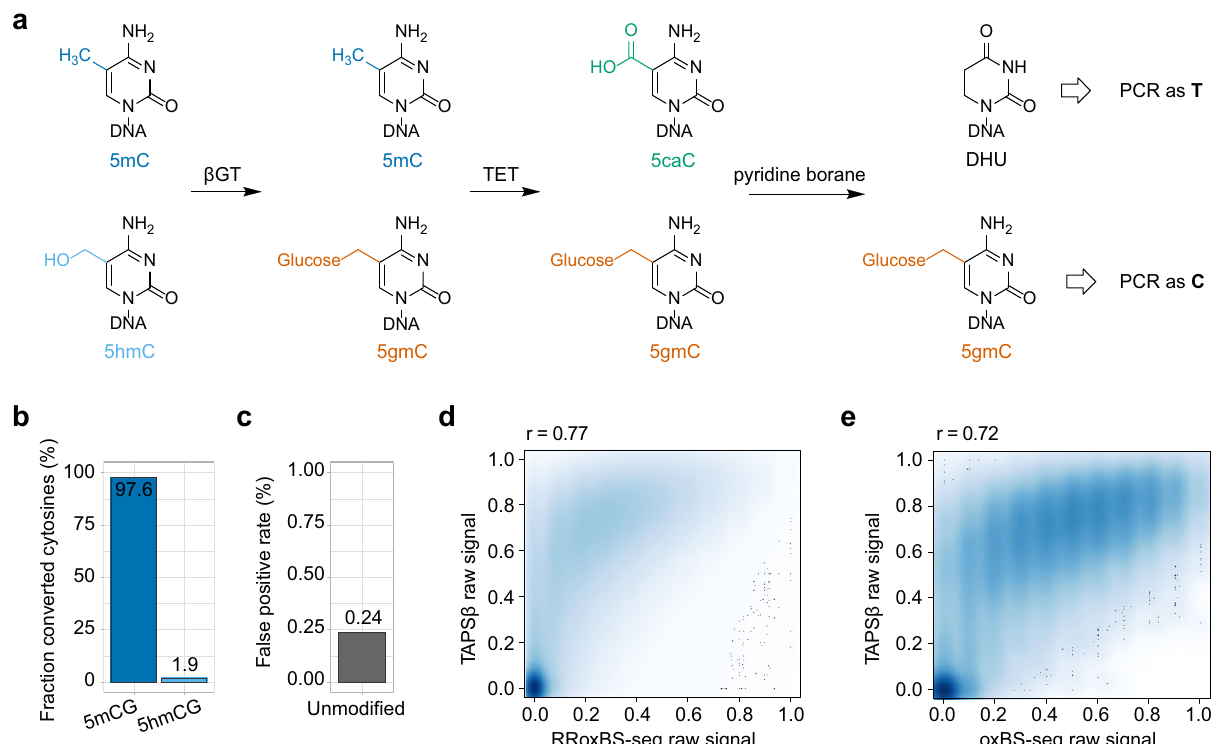
Fig. 1 TAPS β for bisul fi te-free 5mC-speci fi c sequencing. a Schematic demonstration of TAPS β . b Conversion rates of TAPS β at known 5mCG or 5hmCG positions from CpG-methylated lambda DNA or synthetic spike-in. c False-positive rate of TAPS β from 2-kb-unmodi fi ed spike-in. d Correlation analysis between TAPS β and published RRoxBS-seq dataset at CpGs with the minimal depth of 10. The color scale represents density. e Correlation analysis between TAPS β and published oxBS-seq dataset at CpGs with the minimal depth of 10. The Pearson ’ s r is shown at the top. The raw signal for each CpG was calculated as the ratio between C and the sum of C and T.